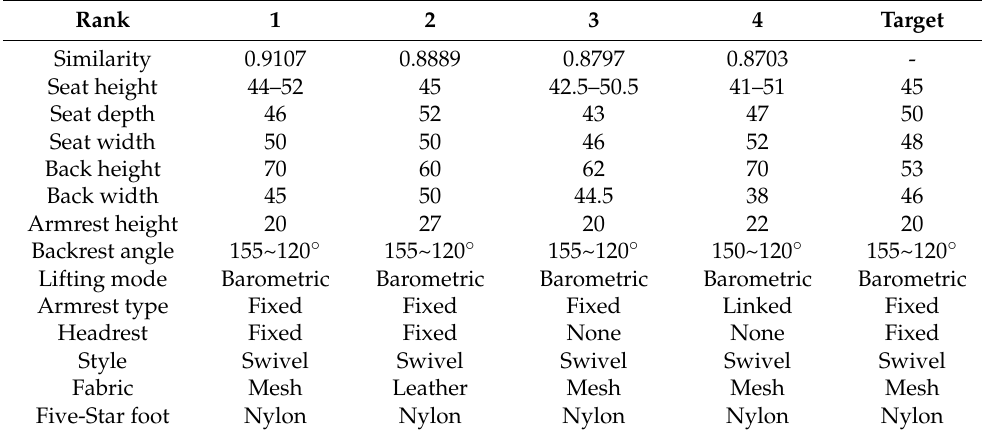
Table 5. The results of the weighted K-NN office chair pattern retrieval.